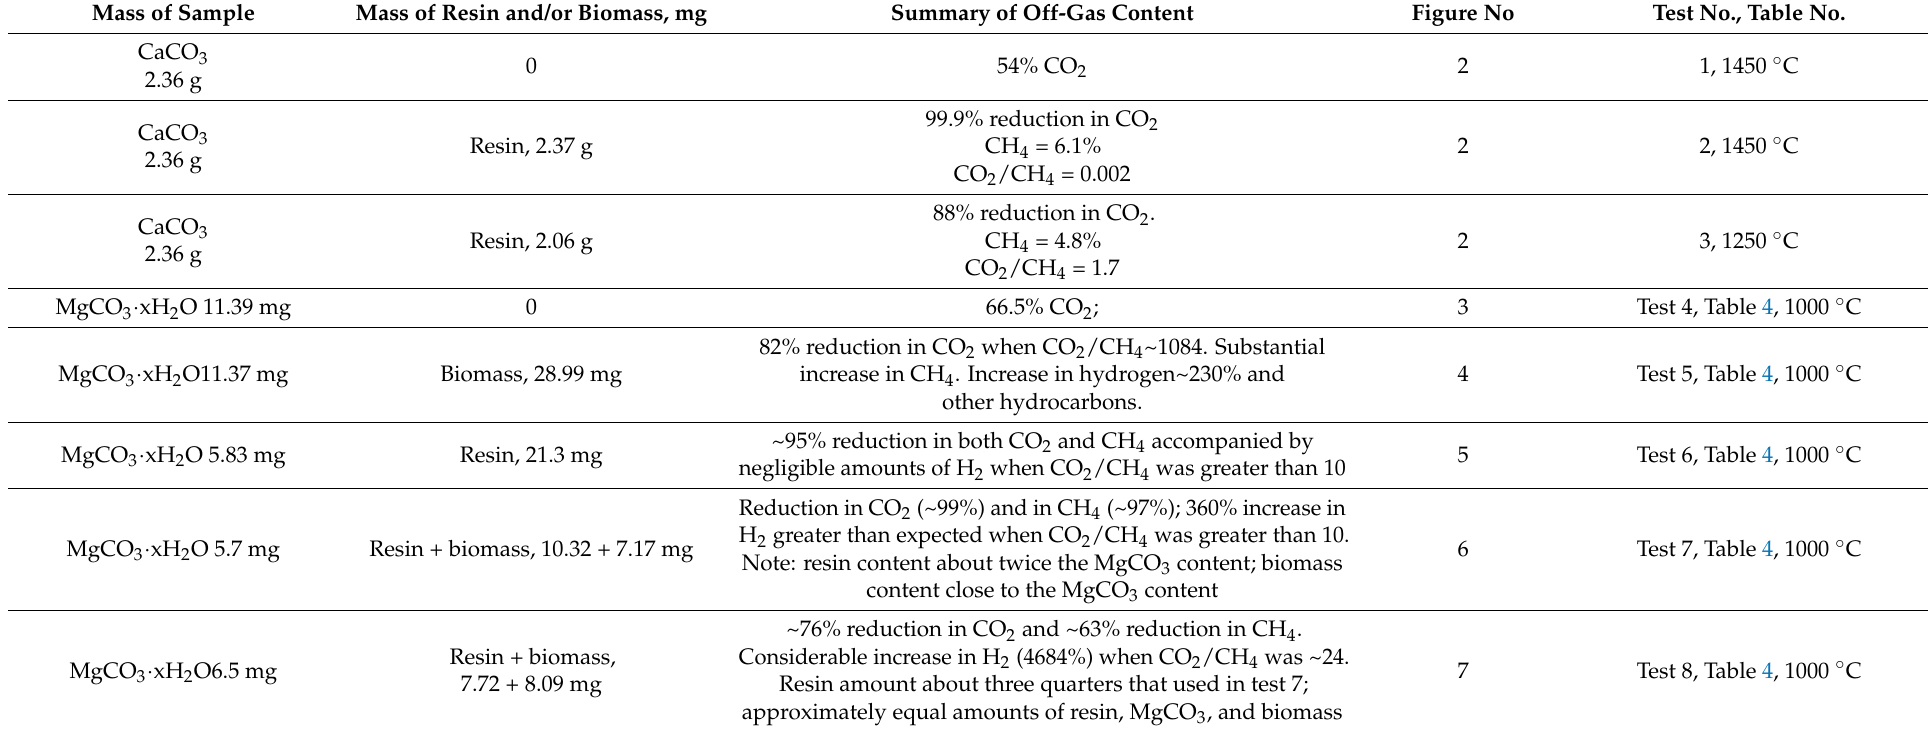
Table 4. Summary of results involving isothermal calcination experiments using CaCO 3 or MgCO 3 · xH 2